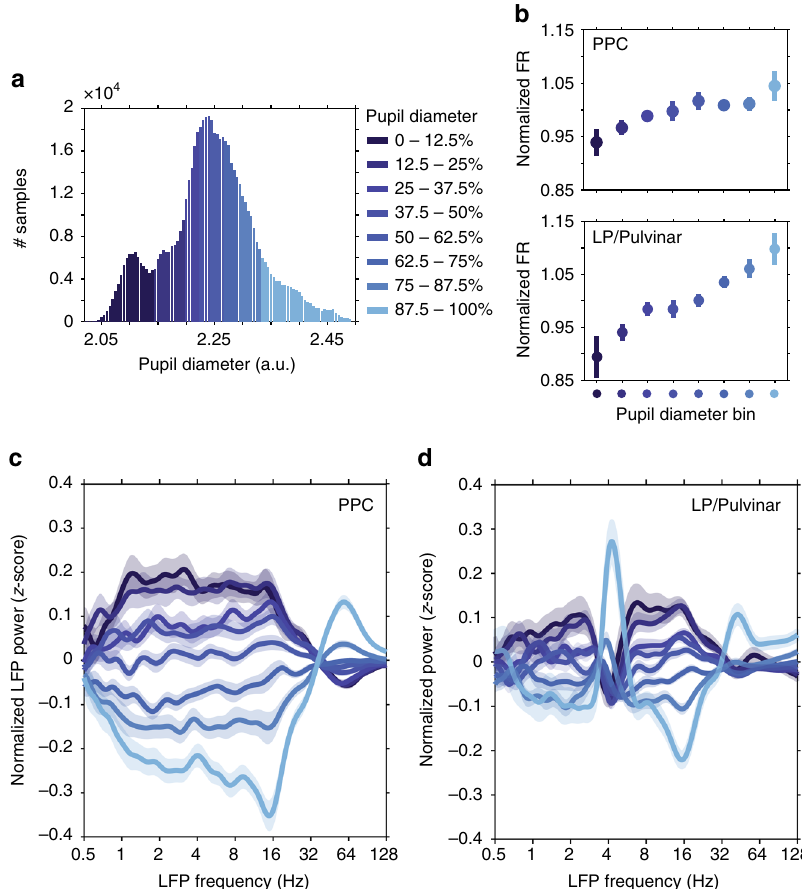
Fig. 2 Neuronal spiking rate and LFP spectral power in PPC and LP/Pulvinar are modulated with pupil diameter. a A representative example of how pupil diameter time series were divided up into bins (each bin represents 12.5% of all samples). Neurophysiological data were then analyzed according to pupil diameter bin. b The normalized spiking rate in both PPC and LP/Pulvinar increases with pupil dilation. Color denotes pupil diameter, as indicated in a . c The mean (±SEM) z -scored LFP power in PPC as a function of carrier frequency across pupil diameter bins. Low (<30 Hz) and high (>30 Hz) frequency LFP power displayed opposing relationships to pupil diameter. d the same as c but for LP/Pulvinar LFP power. Note the antagonism between low- and high- frequency LFP oscillatory power is similar to PPC, with the exception of the theta band ( ∼ 4 Hz), which displays increased power during large pupil